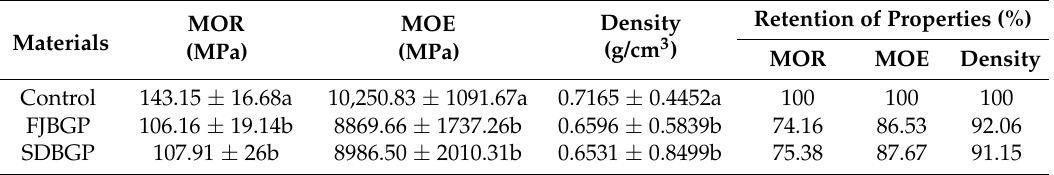
Table 1. The average MOR, MOE, and density of used BGPs and control